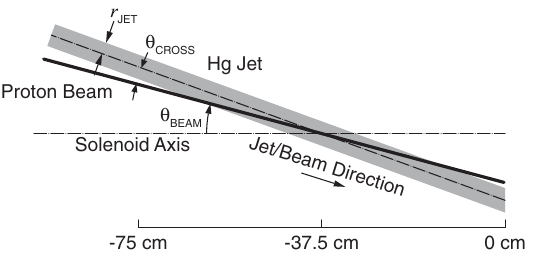
FIG. 3. The mercury jet target geometry. The proton beam and mercury jet cross at z ¼ (cid:2) 37 : 5 cm .